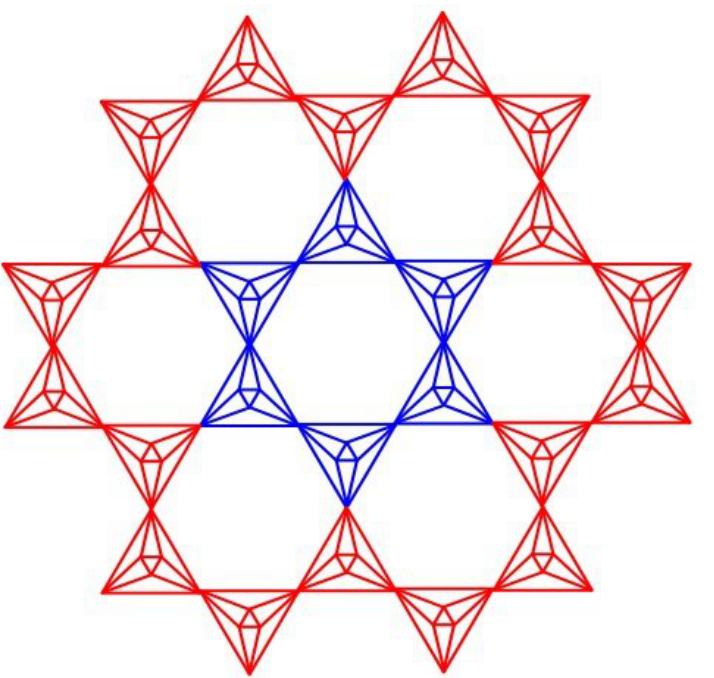
Figure 1. Planar Octahedron network POH ( 2 )